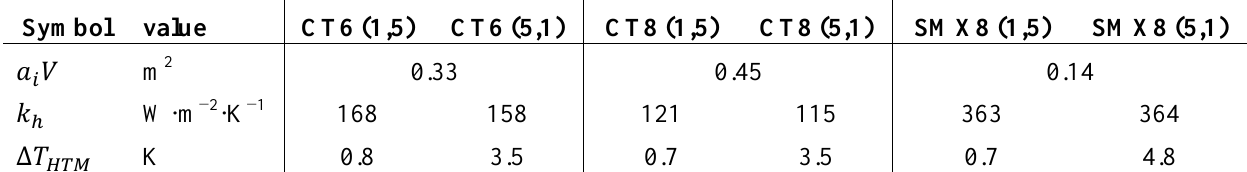
Table 7. Heat transfer area, heat transmission coefficients and characteristic temperature differences to the heat transfer fluid (HTF) for the selected